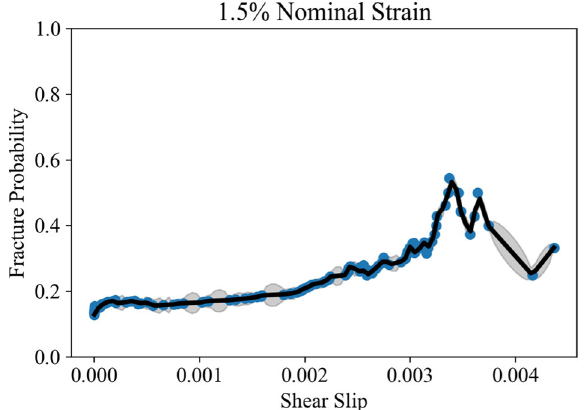
Fig. 15 Predicted probability of failure on test-set data at 1.5%, 1.75% and 2.0% strain levels. The ideal value is 1.0, or 100%